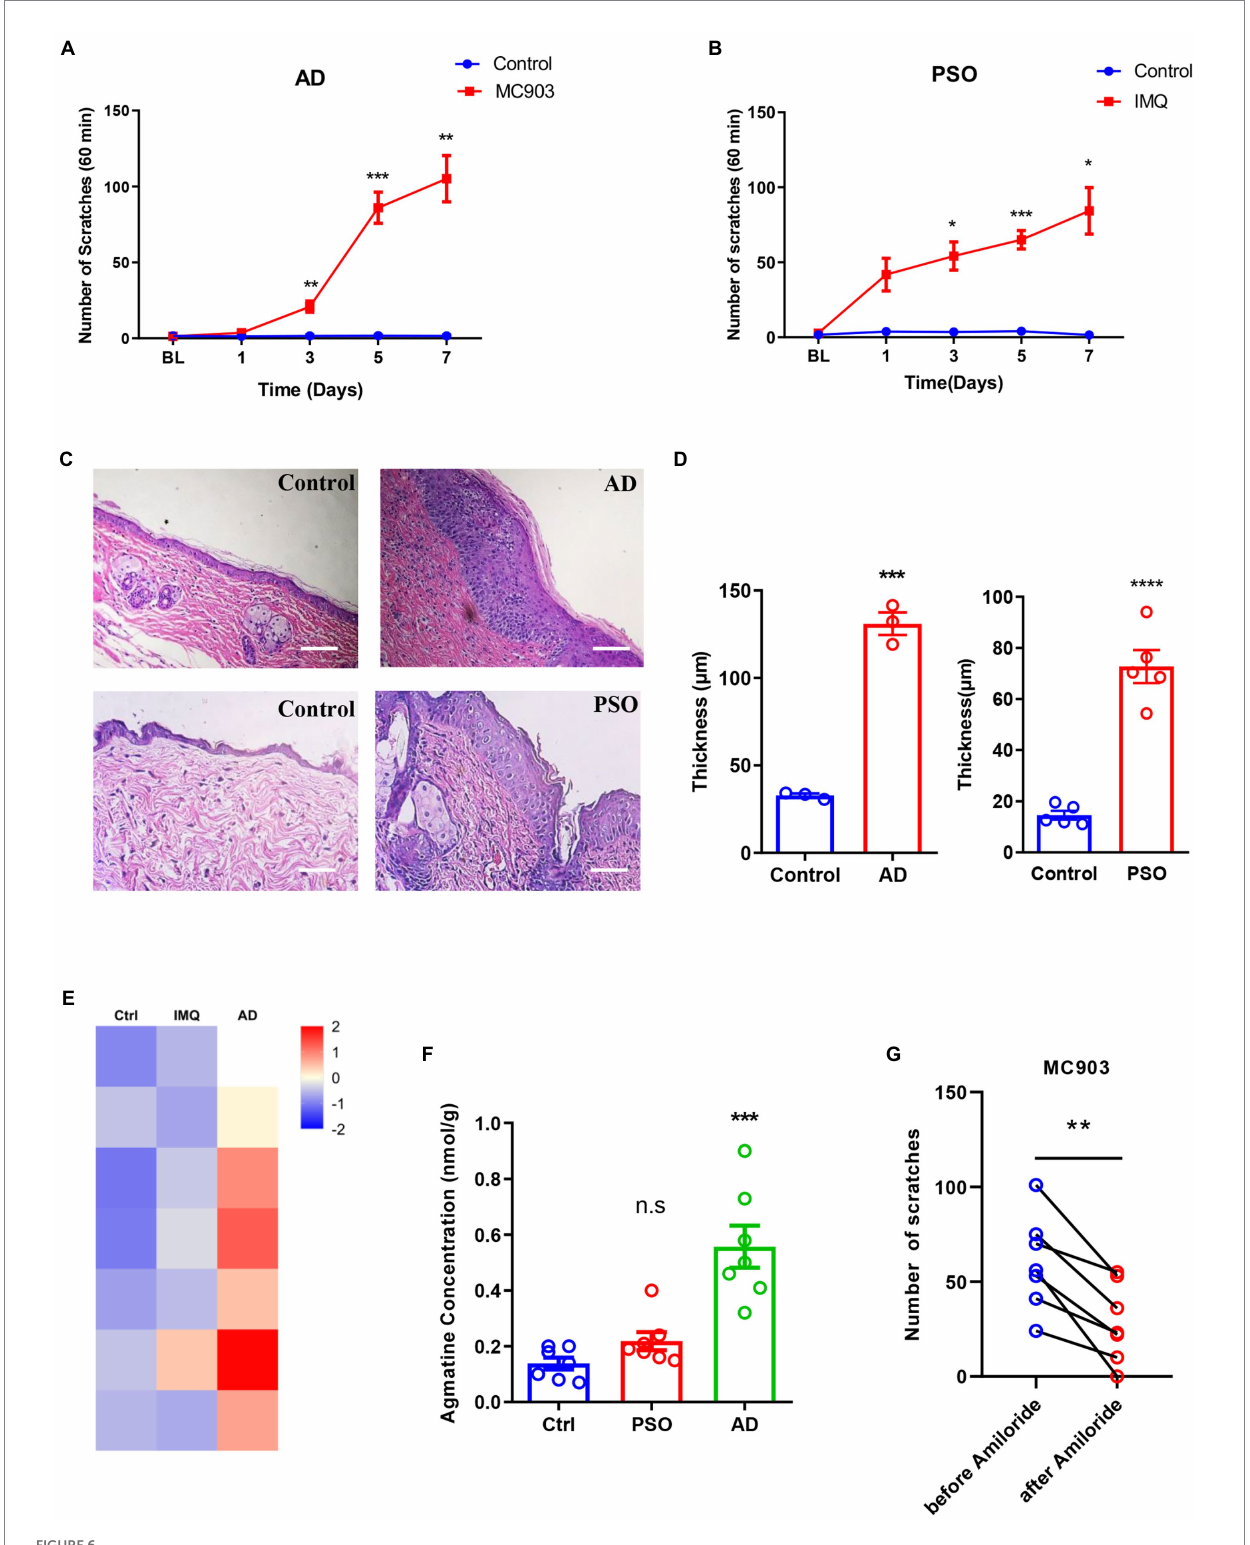
FIGURE 6 Up-regulation of agmatine in atopic dermatitis (AD)-induced itch. (A,B) The number of spontaneous scratching events in an hour on days 1, 3, 5, and 7 of the AD and PAO model mice. (C) Representative images of HE staining of the epidermis of AD and PSO model mice on day 7. Scale bars =50 μ M. (D) Statistical analysis of epidermis thickness in AD and PSO model mice. Metabonomics heat map (E) and statistical analysis (F) of the concentration changes of agmatine in skin samples from AD and PSO models. (G) Blocking ASIC3 significantly reduced the scratching behavior of MC903-induced atopic dermatitis mice (* p < 0.05, ** p < 0.01, *** p < 0.001, **** p < 0.0001 vs. Ctrl, two-way ANOVA, unpaired or paired Student’s t test; n = 3, 5, or 7 per group. The different colors in the metabonomics heat map represent the different concentration of agmatine in different skin samples, these are normalized values range from − 2 to 2, for the value within − 2 to 0, the deeper the colors is, the lower the concentration is; for the value within 0 to 2, the deeper the colors is, the higher the concentration is). All data are expressed by mean ± SEM. Ctrl, control; IMQ,